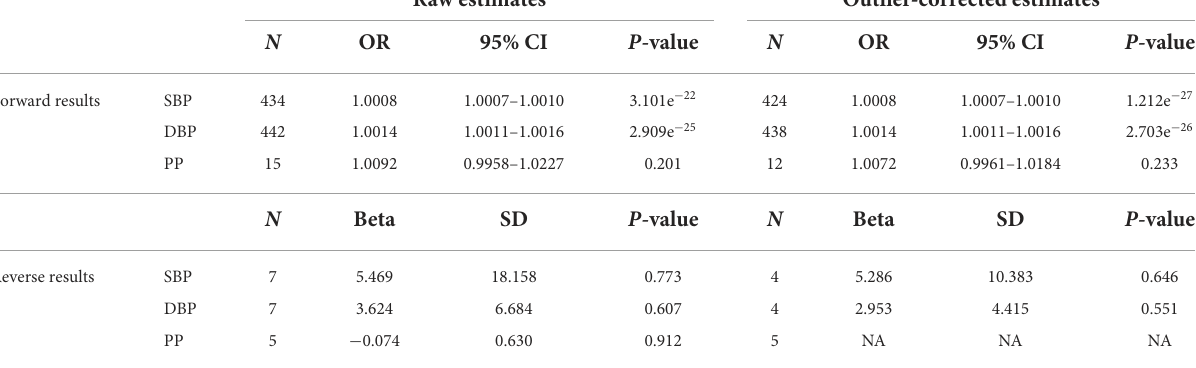
TABLE 3 MR-PRESSO estimates between pressure and myocardial